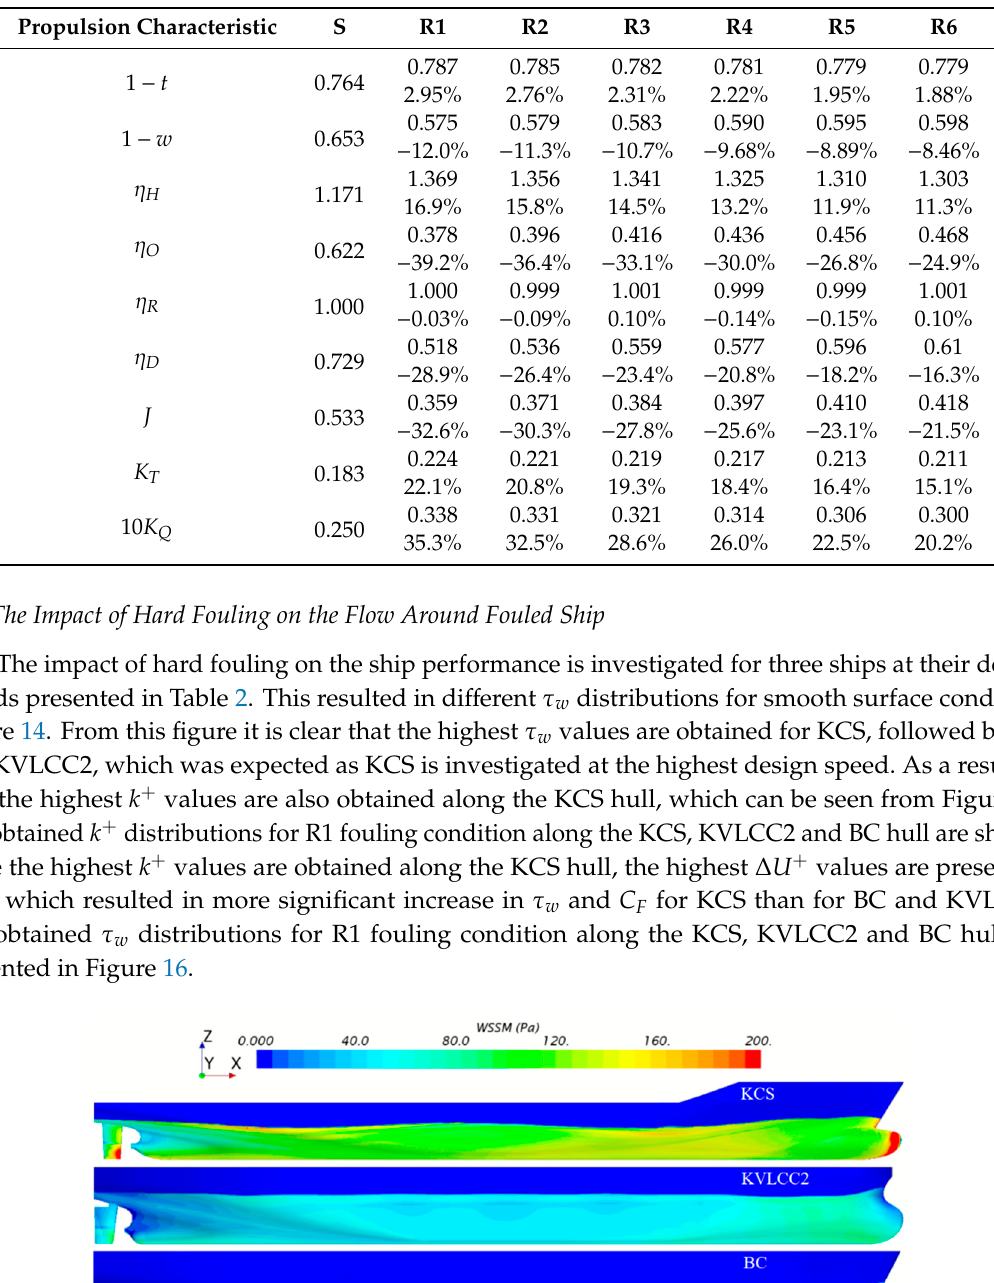
Figure 15. The obtained k + distributions for R1 fouling condition along the KCS ( upper ), KVLCC2 ( middle ) and BC ( lower ) hull. Figure 16. The obtained w τ distributions for R1 fouling condition along the KCS ( upper ), KVLCC2 ( middle ) and BC ( lower ) hull. The increase in w τ along the hull causes a decrease in the velocity in the turbulent boundary layer, i.e., turbulent boundary layer thickness increases due to the presence of roughness, which can be seen from Figure 17. In this figure, boundary layers, which are defined as the distance between the hull surface and the point where the axial velocity magnitude of the flow reaches the proportion of 0.99 of the ship speed, are shown for smooth and R1 surface condition. The boundary layers for KCS are given at locations x = 30 m and x = 50 m, for KVLCC2 at locations x = 50 m and x = 70 m and for BC at x = 17.5 m and x = 35 m. The obtained increases in the boundary layer thickness, due to the presence of biofouling or roughness, is in line with previously published experimental results in the literature [43,44].